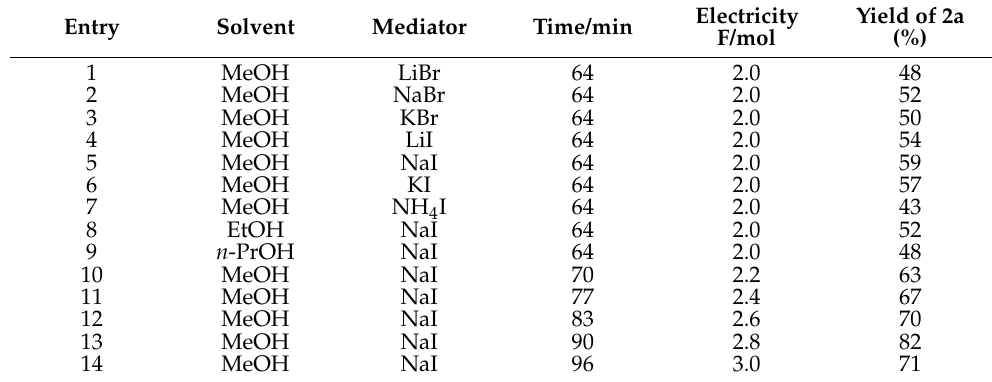
Table 1. Electrocatalytic multicomponent synthesis of spiro[furo[3,2- b ]pyran-2,5 ′ -pyrimidine] 2a .